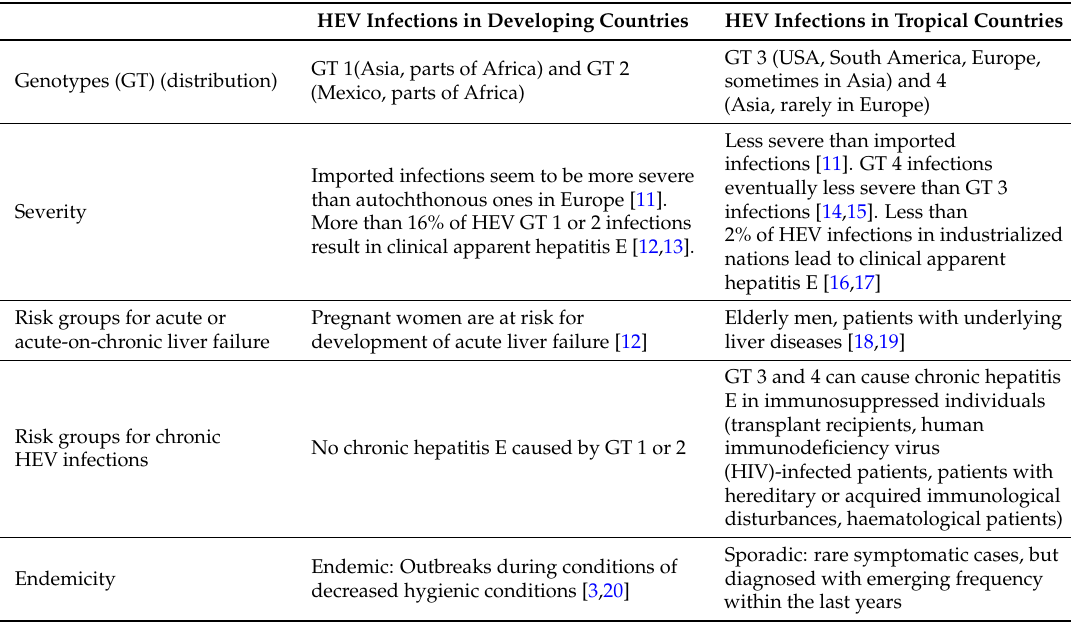
Table 1. Differences between hepatitis E virus (HEV) infections in developing and industrialized nations. HEV Infections in Developing